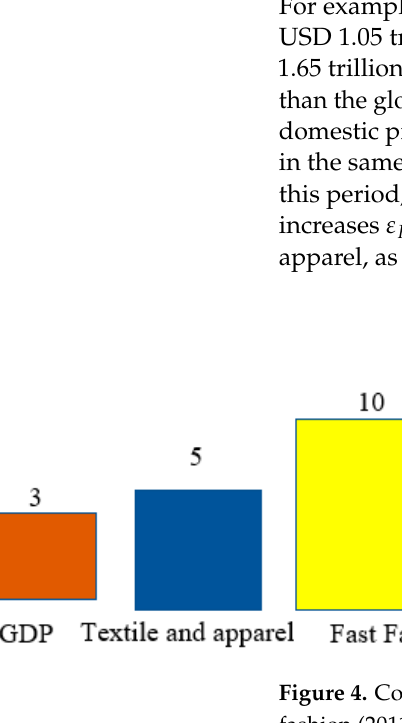
both their functional and supra-functional (emotional, social, and cultural) requirements.